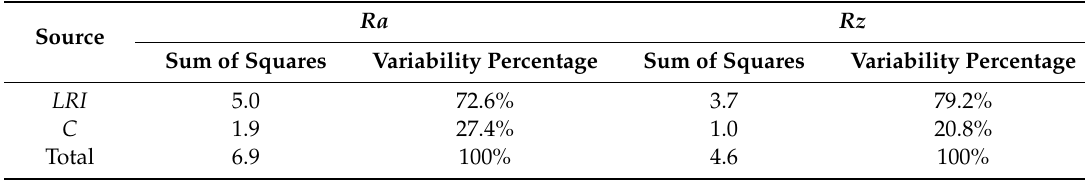
Table 13. Percentage variability of the statistically significant e ff ects obtained from ANOVA. Ra Rz Source Sum of Squares Variability Percentage Sum of Squares Variability Percentage